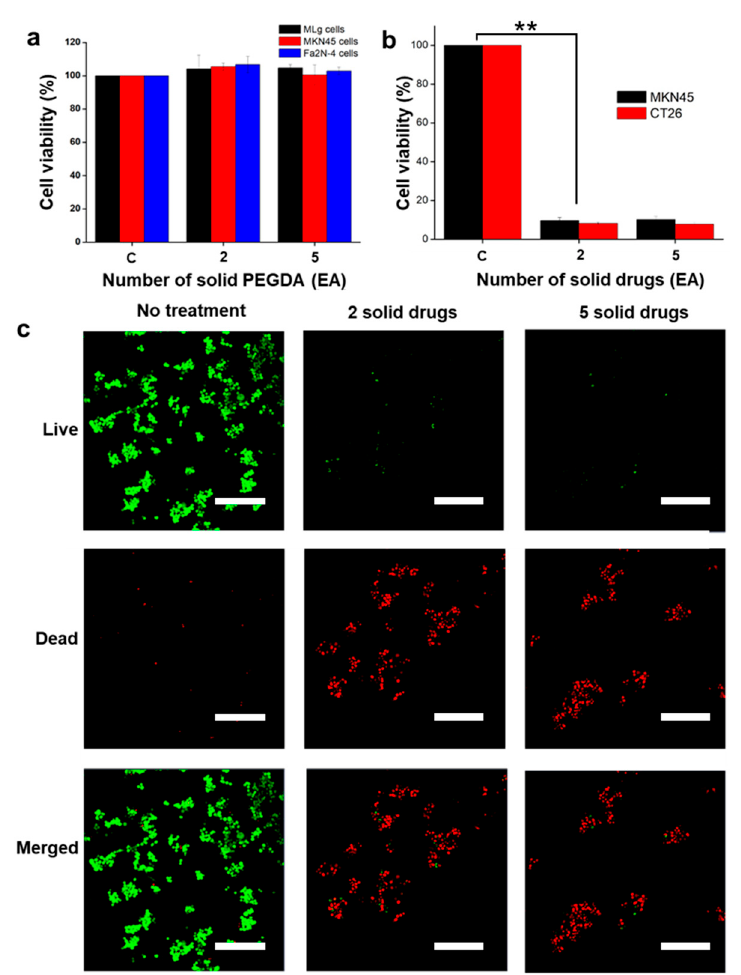
Figure 5. Cell studies assessing treatment with the fabricated PEGDA alone or with solid drugs: ( a ) Biocompatibility of PEGDA, when the treatment was conducted for 24 h against MLg cells, MKN45 cells and Fa2N-4 cells. The lack of reduction in cell viability indicates that the PEGDA is biocompatible; ( b ) Cytotoxicity of the solid drugs against CT26 and MKN45 cancer cells after 24 h. The reduction in cell viability indicates that the solid drugs can effectively release the drugs and successfully kill the cancer cells. (** p < 0.01, Student’s t -test; n = 3); ( c ) Live (green) and dead (red) cell imaging of the solid drugs against MKN45 cancer cells (scale bar: 200 µm).